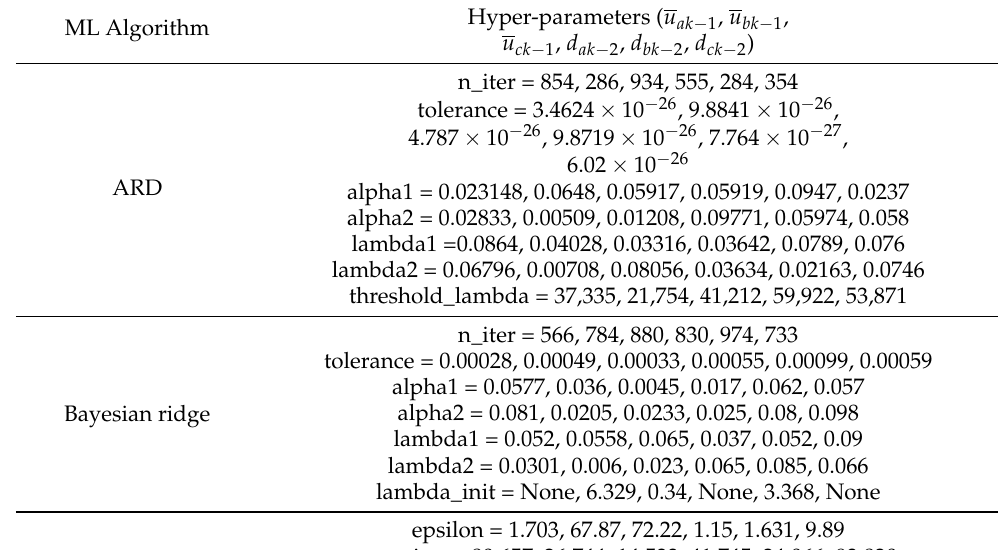
Table 13. The hyper-parameters of each ML-algorithm in randomized hyper-parameter search with 5-fold